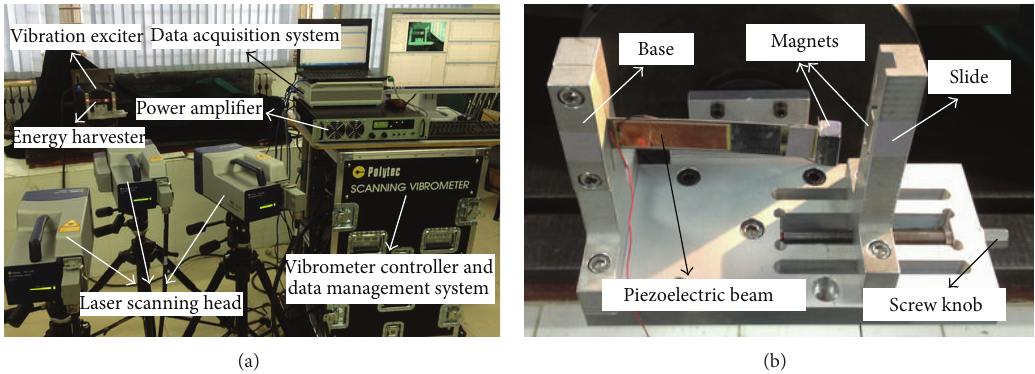
Figure 14: Schematic of the experimental setup: (a) overall layout and (b) bistable piezoelectric generator device.